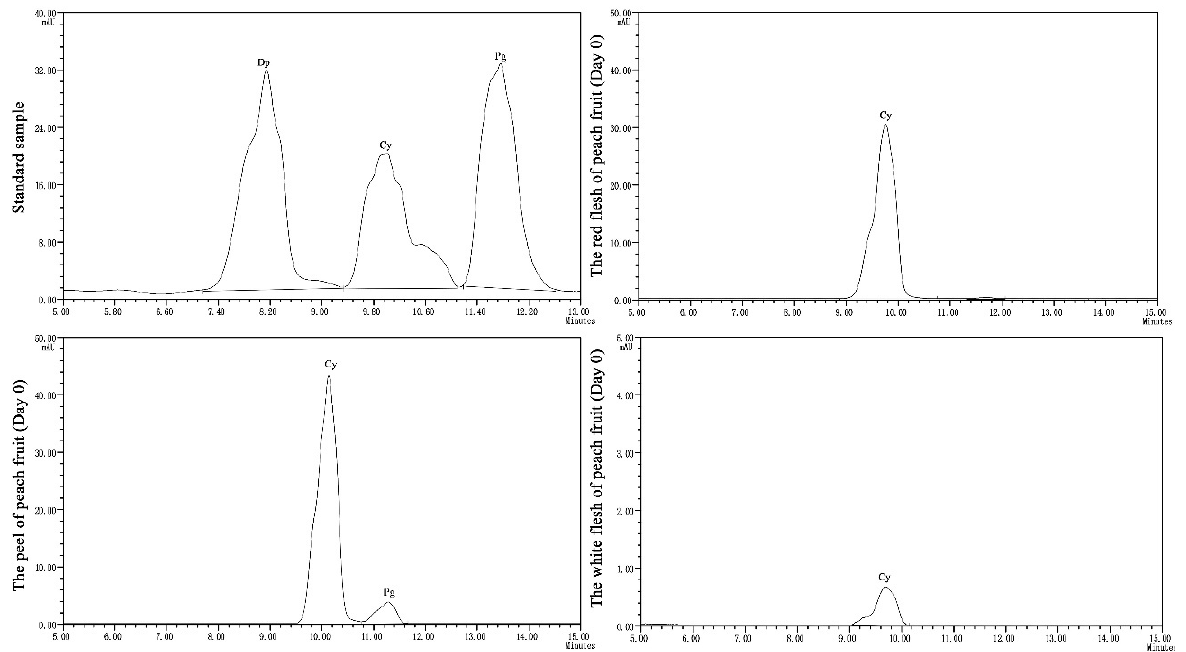
Figure 8. High performance liquid chromatograms (HPLC) of anthocyanin from ‘Yonglian No.1’ peach fruits (Dp: delphinidin-3- O -glucoside, Cy: cyanidin-3- O -glucoside, Pg: pelargonidin-3- O -glucosided).